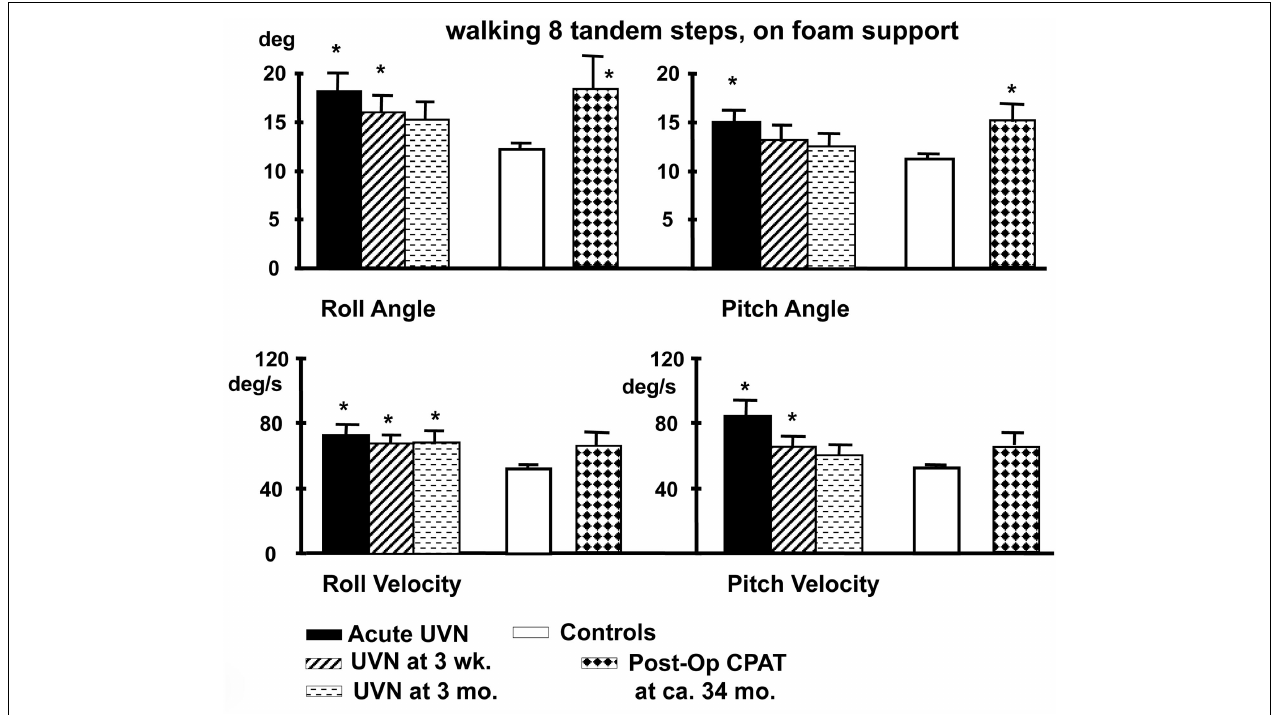
walking eight tandem steps on a foam support surface. For details of the figure refer to the legend of Figure 4 . Note that the angular sway of the CPAT patient is approximately equal to that of the acute UVN patients 3months after onset. Data from Allum and Adkin (2003), Beule and Allum